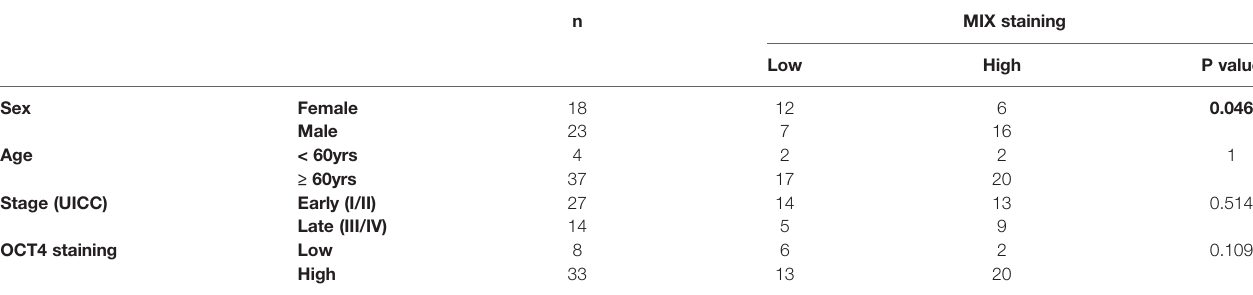
TABLE 1 | Evaluation of the relationship between each clinicopathological characteristic (Sex, Age and pTNM staging) of non-chemotherapeutic-treated patients (n = 41, Table S1 ) and intensity of MIX staining (Low/High) by Chi-squared statistic. n MIX